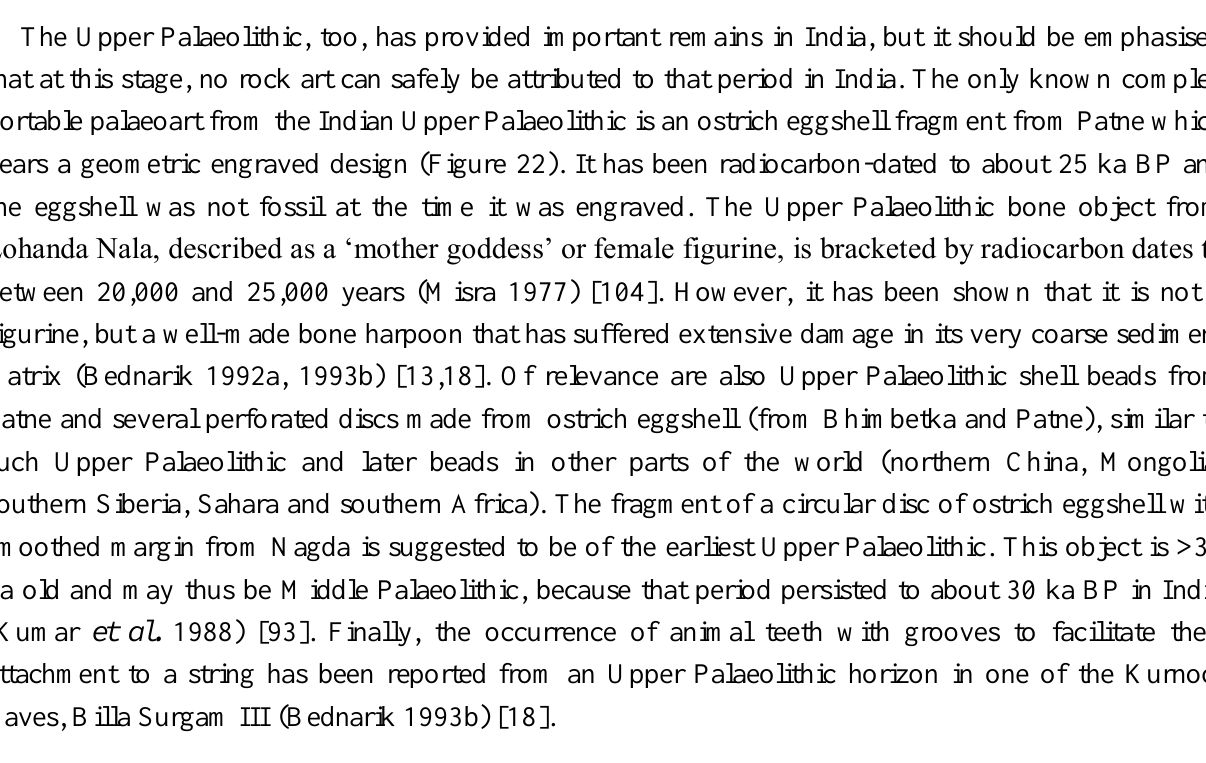
Figure 22. Engraved ostrich eggshell fragment from Patne, western India, c. 25,000 years